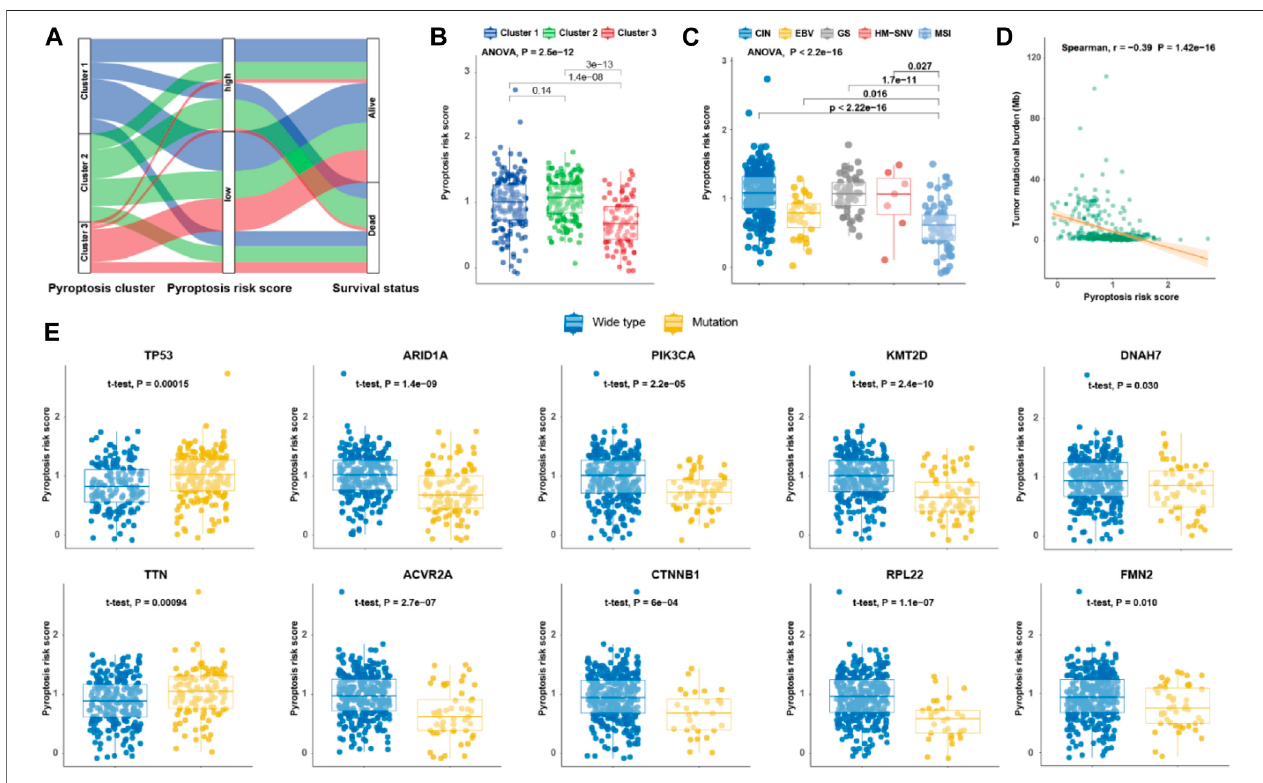
FIGURE3| Molecularfeaturesofpyroptosisriskscoreforgastriccancer. (A) Alluvialdiagramofpyroptosisclusters,pyroptosisriskscore,andsurvivalstatus. (B,C) Dot plot depicting the pyroptosis risk score in the three pyroptosis clusters, and TCGA molecular subtypes, respectively. (D) Scatter plot of correlation between pyroptosis risk score and tumor mutational burden. (E) Dot plot showing the pyroptosis risk score of 10 driver genes in gastric cancer regarding each mutation status.